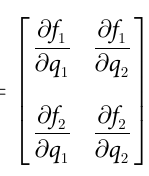
S1 Fig. Schematic depiction of a two-deme gene-drive model with selection occurring before migration. For interpretation of arrow colors, see Fig 1 in the main text. S2 Fig. Critical migration thresholds for differential targeting in the two-deme model